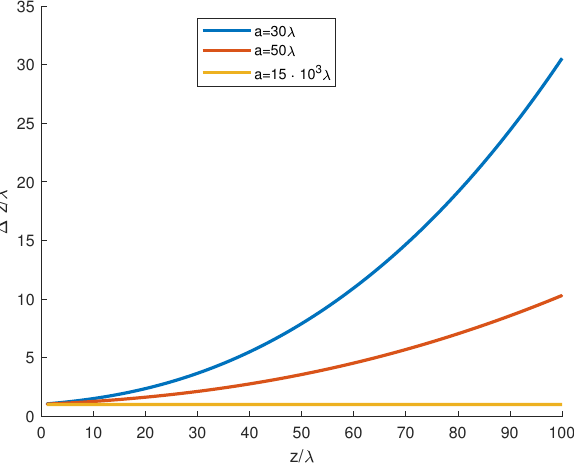
Figure 3. Resolution returned by (30) for different values of aperture